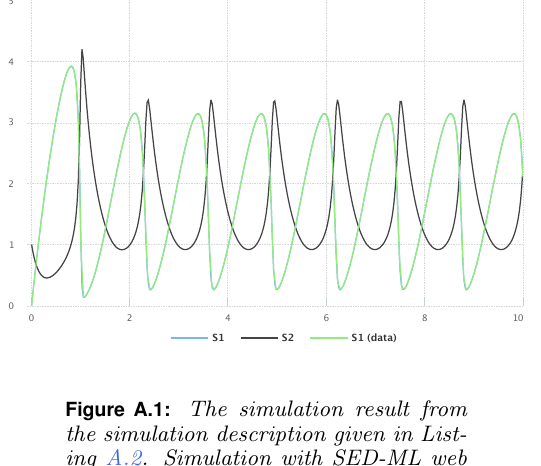
Figure A.2: Simulation with tellurium